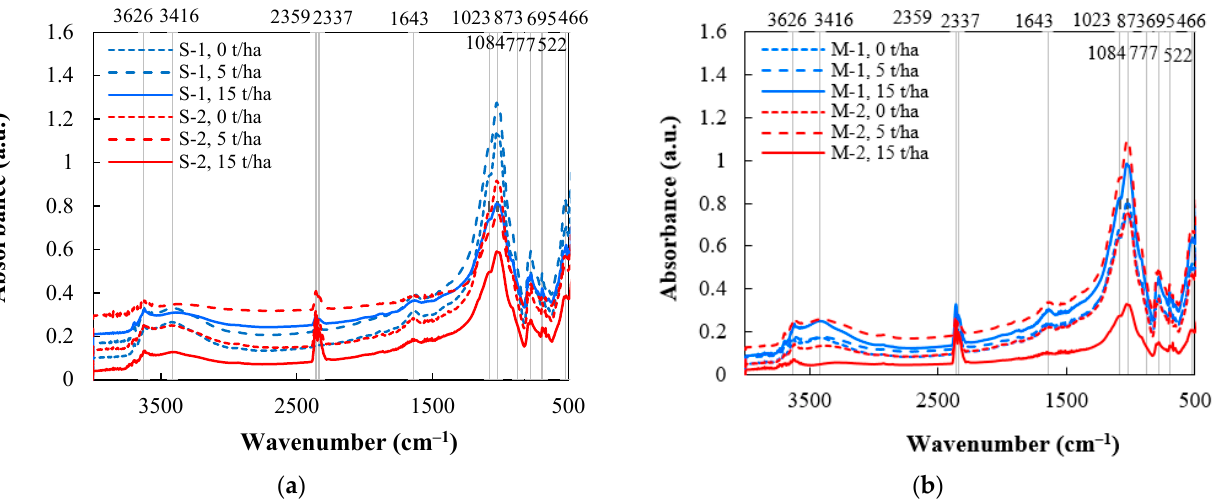
Figure 8. Impact of biochar on the soil surface functional groups in different tillage-fertilization systems after 3 months from biochar application: ( a ) S—ploughless shallow tillage, ( b ) direct drilling, 1—unfertilized, 2—fertilized, n = 2.